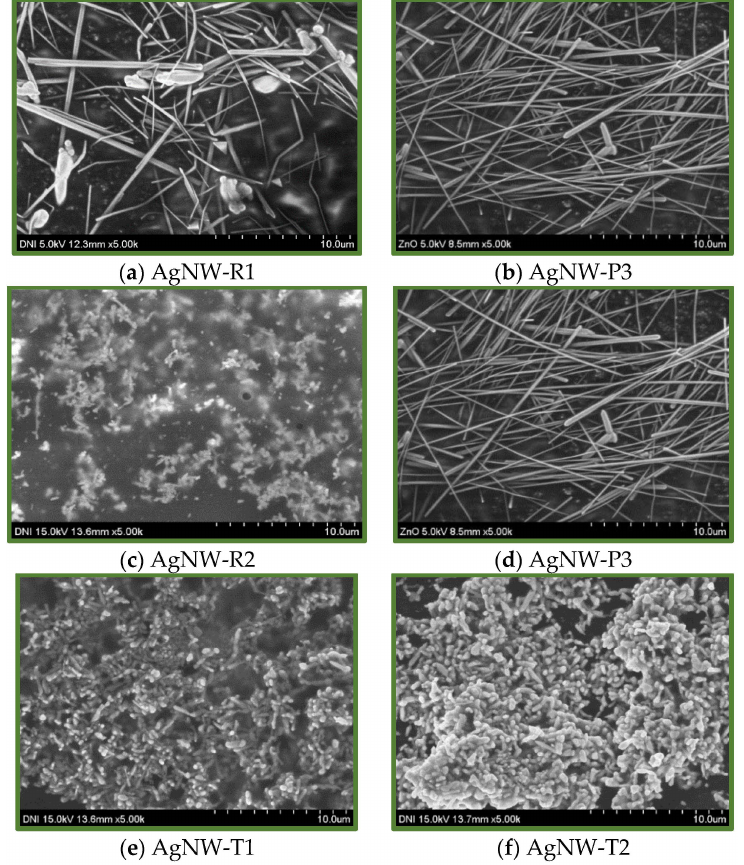
Figure 3. SEM images of AgNWs synthesized by varying magnetic stirrer speed after addition of AgNO 3 in EG solution at ( a ) 80 rpm; ( b ) 250 rpm; and ( c ) 500 rpm and by varying reaction time; ( d ) 5 min; ( e ) 10 min; and ( f ) 15